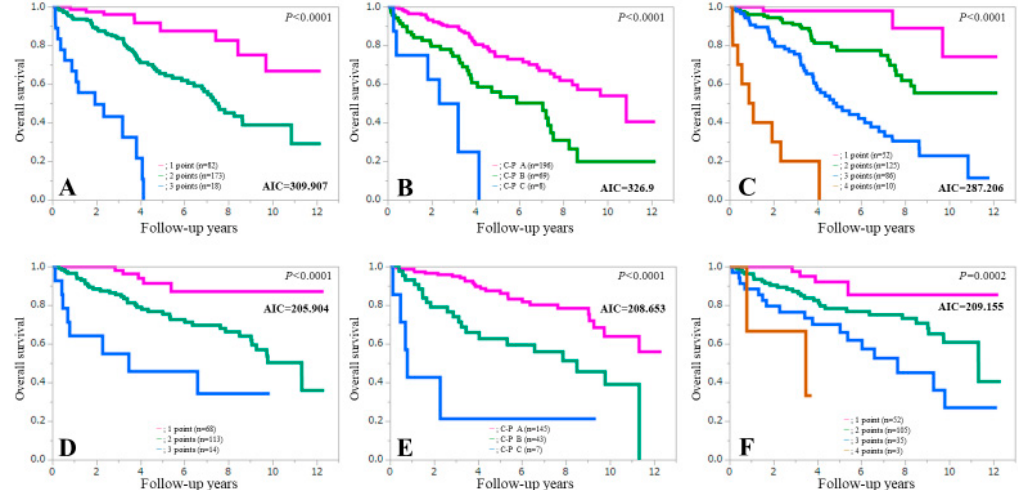
Figure 7. Kaplan-Meier curves in patients aged 65 years or more ( n = 273) according to the ALBI grade ( A ), the Child-Pugh classification ( B ) and the ALBI-SMM grade ( C ), and Kaplan-Meier curves in patients aged less than 65 years ( n = 195) according to the ALBI grade ( D ), the Child-Pugh classification ( E ) and the ALBI-SMM grade ( F ).